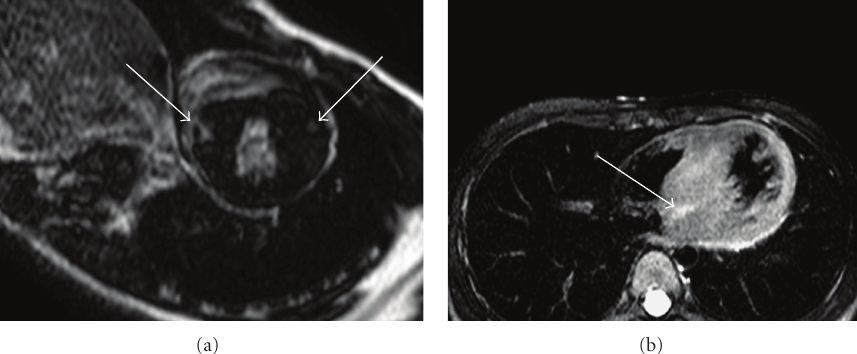
Figure 7: 77-year-old female with hypertrophic cardiomyopathy presenting with chest pain. Delayed-enhancement MRI (a) shows patchy enhancement at the anterior and inferior septal myocardium (arrows). T2-weighted cardiac MRI (b) shows myocardial edema at the inferior and inferior septal myocardium